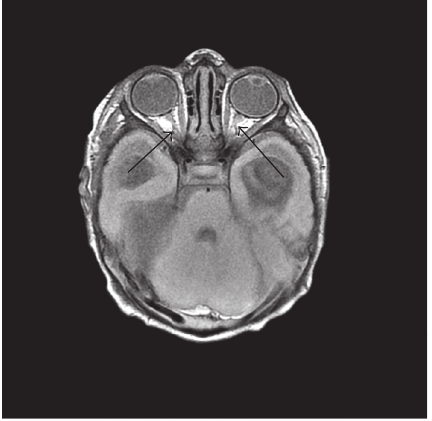
Figure 2: The black arrows indicate the hypoplastic optic nerves.